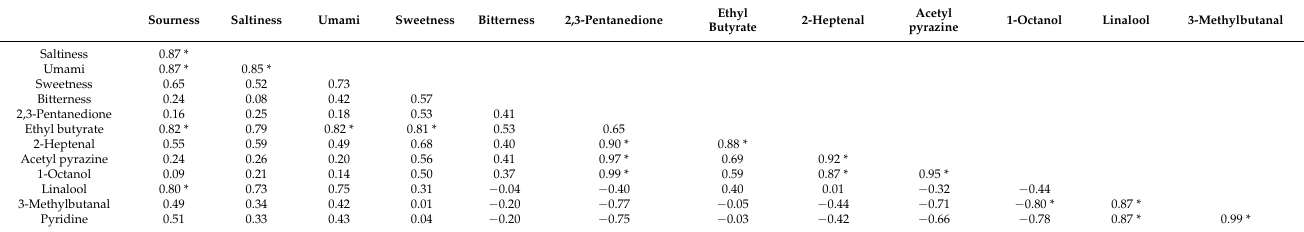
Table 3. Pearson correlation coefficients between taste and flavor compounds in repetitive frying